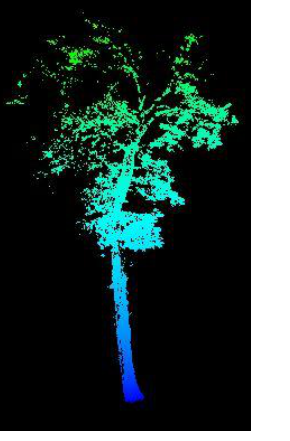
Figure 6. An example of extracted point cloud data of a tree